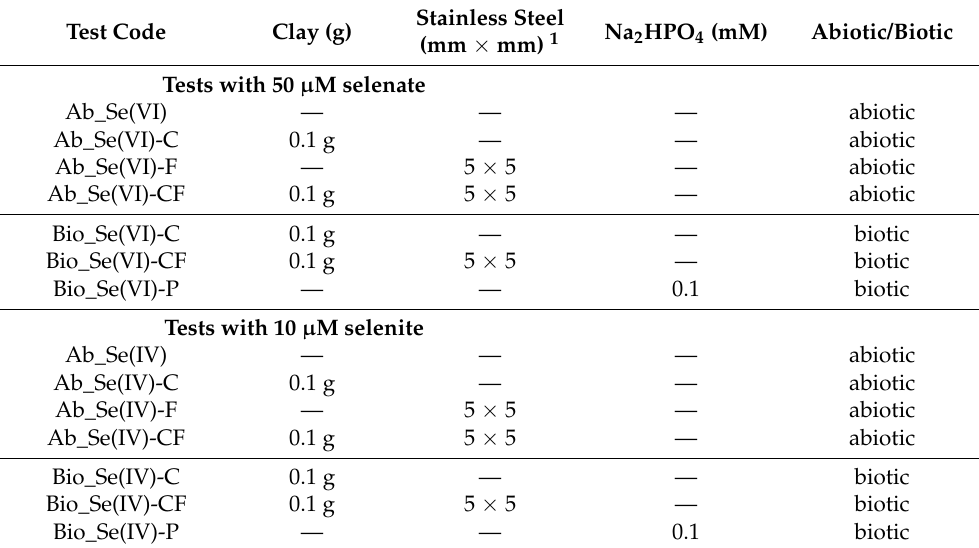
Table 2. Overview of the test conditions studied in the batch tests with Se species. Duplicates were prepared for each condition and were labeled with ‘a’ and